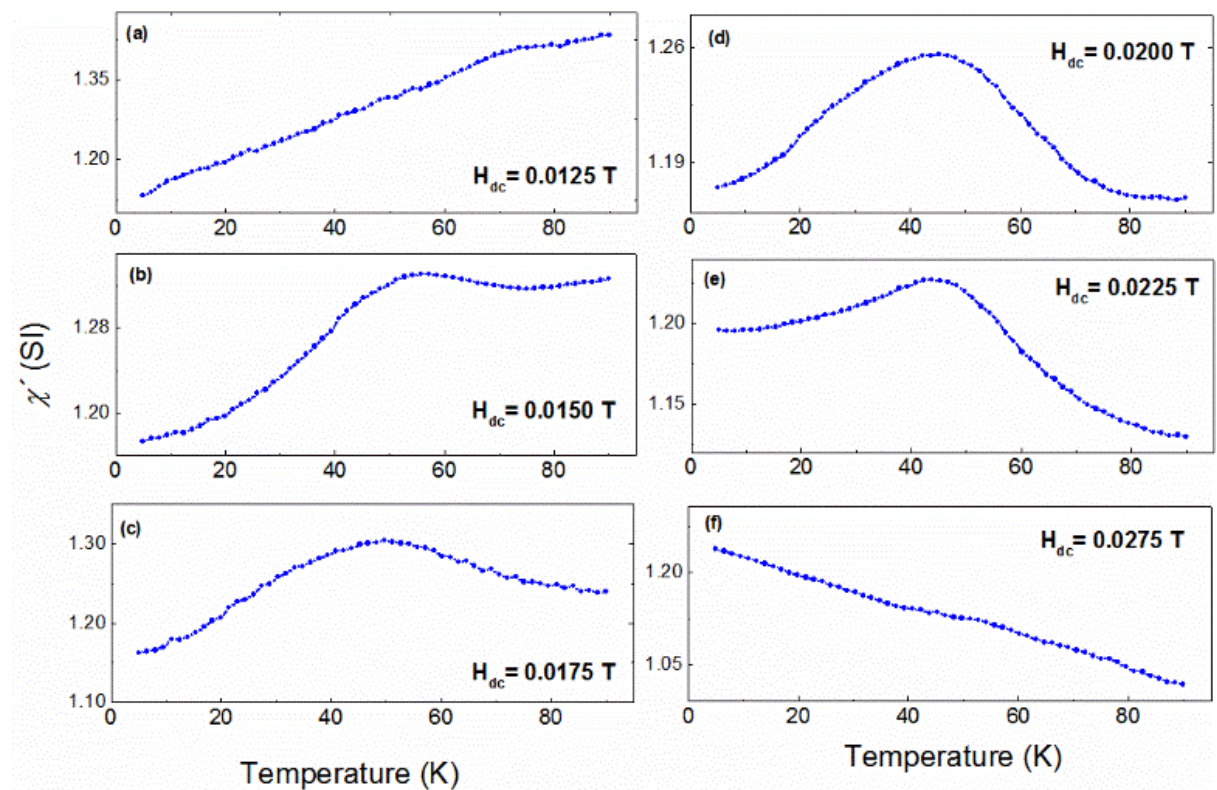
Figure 6. Evolution of the AC susceptibility peak close to 42 K after ZFC, as a function of temperature for different DC bias fields (H dc ) at 178 Hz; ( a ) H dc = 0.0125 T, ( b ) H dc = 0.0150 T, ( c ) H dc = 0.0175 T, ( d ) H dc = 0.0200 T, ( e ) H dc = 0.0225 T, ( f ) H dc = 0.0275 T.